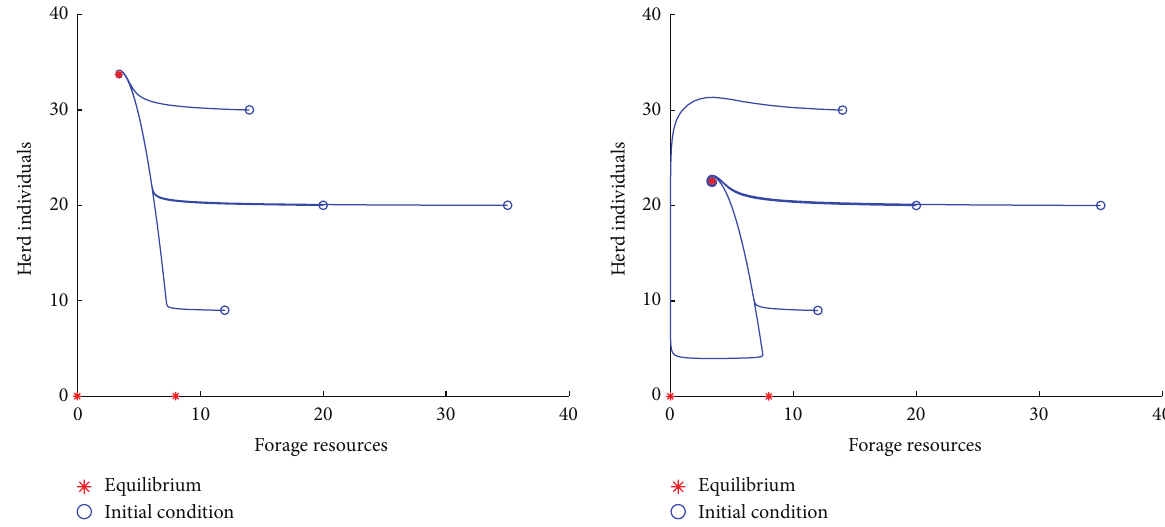
Figure 5: Phase portrait of the herd’s animals and forage resources of System (1) when 𝑟 = 500 kgDM/ha, 𝑒 = 0.05/ day, 𝑎 = 0.013/ ha, 𝐾 = 8 – 30 kgDM/ha, 𝑞 = 0.4/ day, and 𝛾 = 0.07/ day. Illustration of the stability of the unique coexisting equilibrium 𝐸 initial